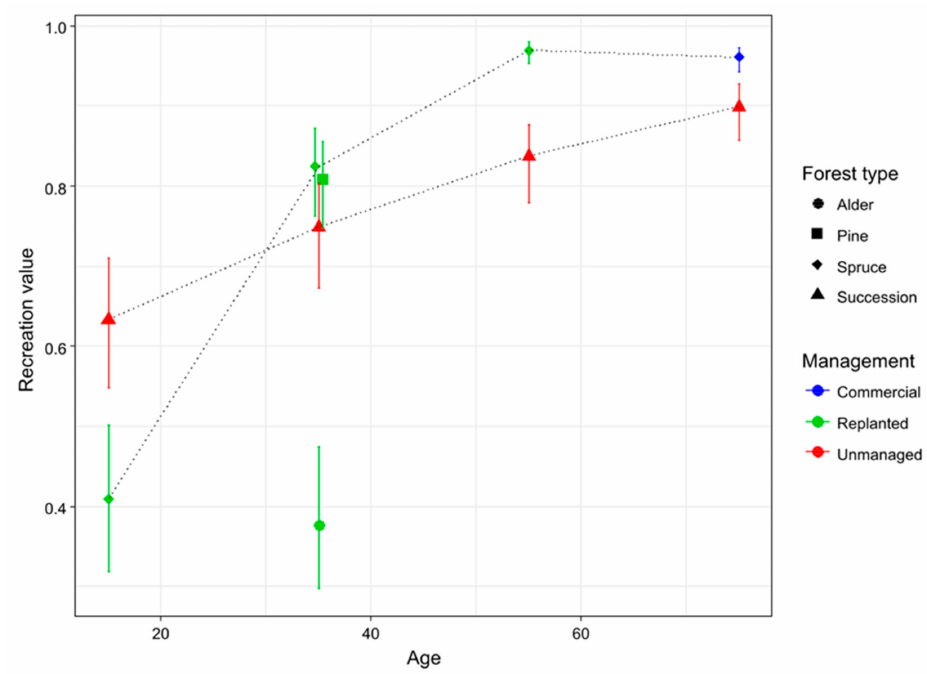
Figure 5. Mean recreation values of reclaimed forests (measured indirectly and predicted by multi- nomial logit model (MNL)). Indirect measure assessed recreation value with a person’s choice of a locality for recreation in a discrete choice experiment. The symbols of forest types display the mean choice probability of forests compared to an opt-out choice of Scheme 95. confidence intervals for